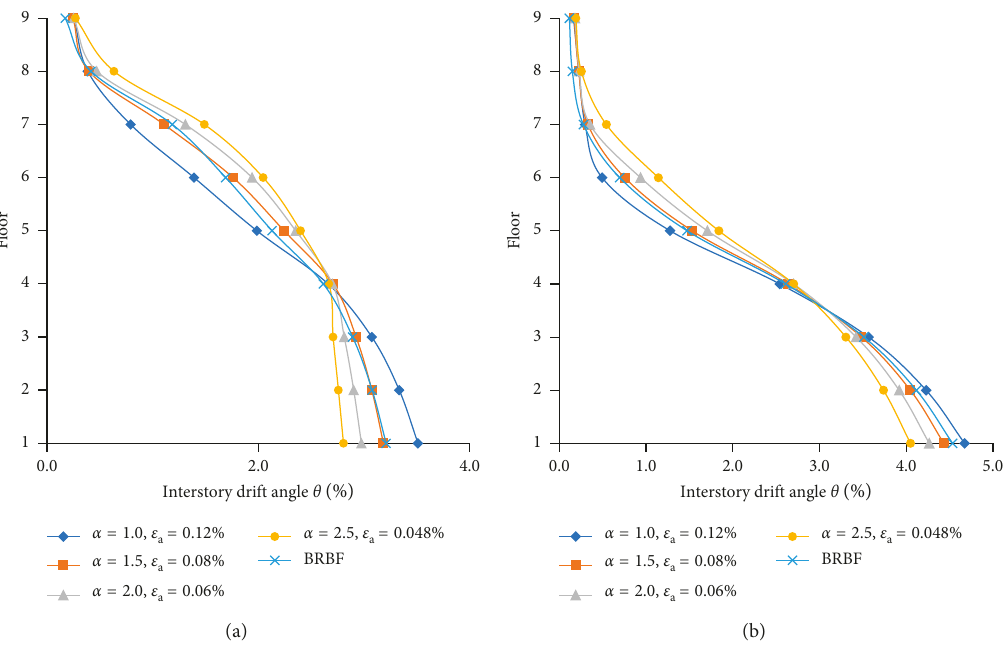
Figure 26: The effects of ε and α on the interstory drifts of 9-story SC-TOBFs: (a) LD-1 and (b) a